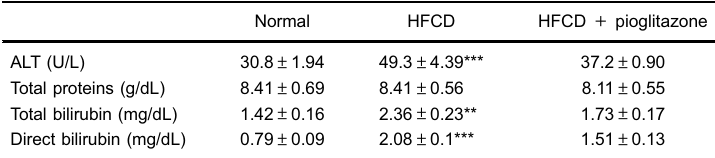
Table 1. Effect of high fat-carbohydrate diet (HFCD) and HFCD + pioglitazone on liver integrity, alanine transaminase (ALT), total proteins, total bilirubin, and direct bilirubin.